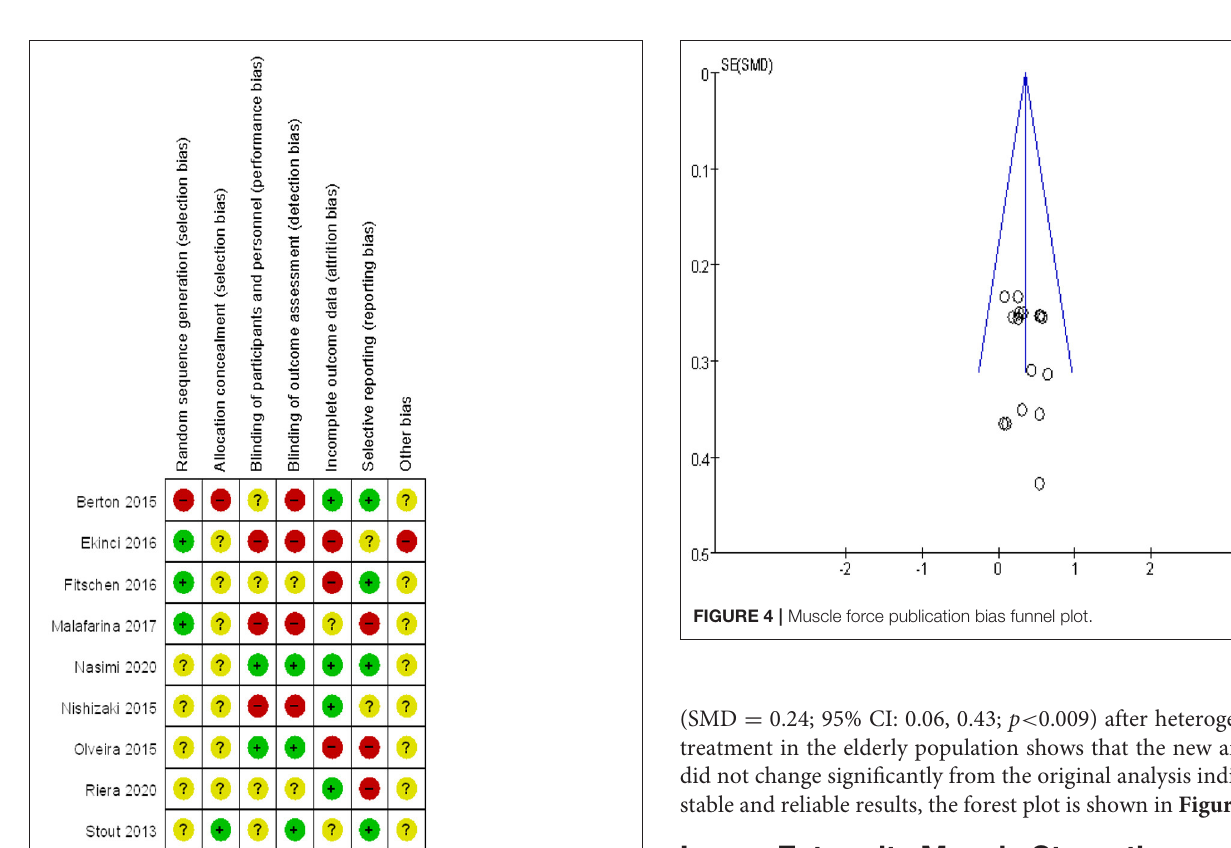
reanalyzing it, the heterogeneity test ( p = 0.91, I 2 = 0%) showed no statistically significant heterogeneity. The effect size results